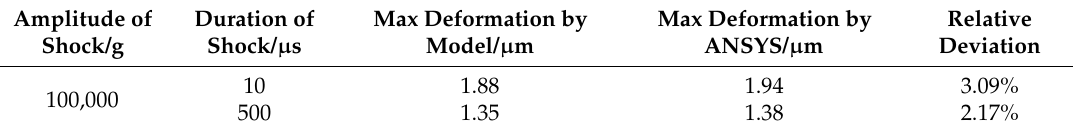
Table 5. Maximum deformations of the inductor with double auxiliary pillars, as calculated by ANSYS and the proposed